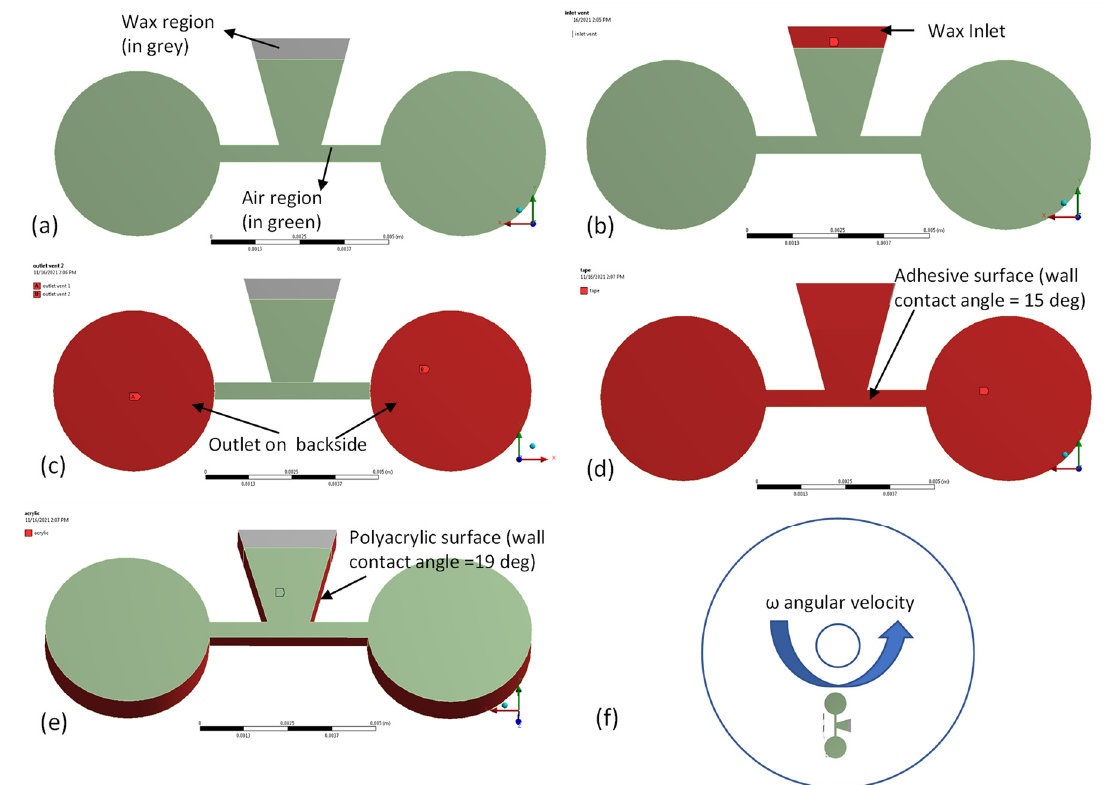
Figure 5. ( a ) Simplified 3D geometry used in the ANSYS simulation with the molten wax region represented by grey (volume fraction (VF) ferrowax = 1, VF air = 0) and the air region represented by green (VF ferrowax = 0, VF air = 1). We use different colors to show two different phases and their presence region-wise. ( b ) The location of the inlet for the molten wax (VF ferrowax = 1, in red); ( c ) the location of the outlet (the 3D model is flipped to the backside) on the bottom of the two fluidic chambers (in red); ( d ) the adhesive layer (in red) forms the top surface on the wax chamber and the valve channel; ( e ) the location of the acrylic surface (in red); ( f ) the position and orientation of the wax valve on a disc and the direction of rotation of the